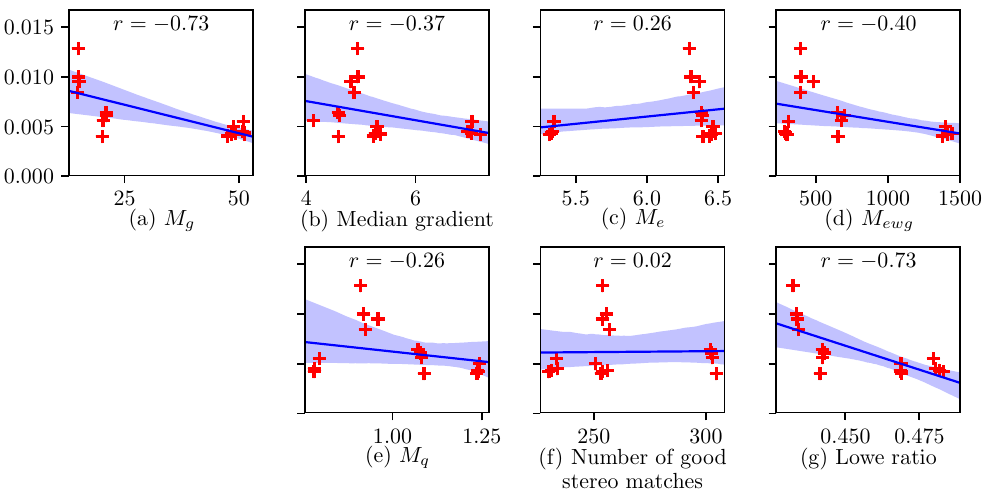
Figure 9. Linear regression and 95% confidence region for different candidate proxies of VO performance: ( a ) Gradient information metric (5). ( b ) Median gradient. ( c ) Entropy metric (2). ( d ) Entropy-weighted gradient metric (12). ( e ) Quality metric (14). ( f ) Number of good stereo matches. ( g ) Lowe ratio for the stereo